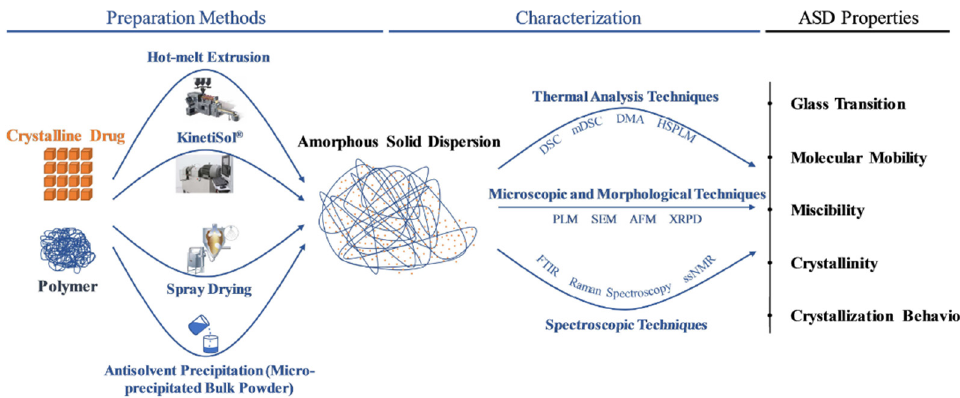
Figure 8. ASD preparation and characterization flow chart. Adapted with permission from [60] Ma et al., Journal of Drug Delivery Science and Technology, published by Elsevier, 2019